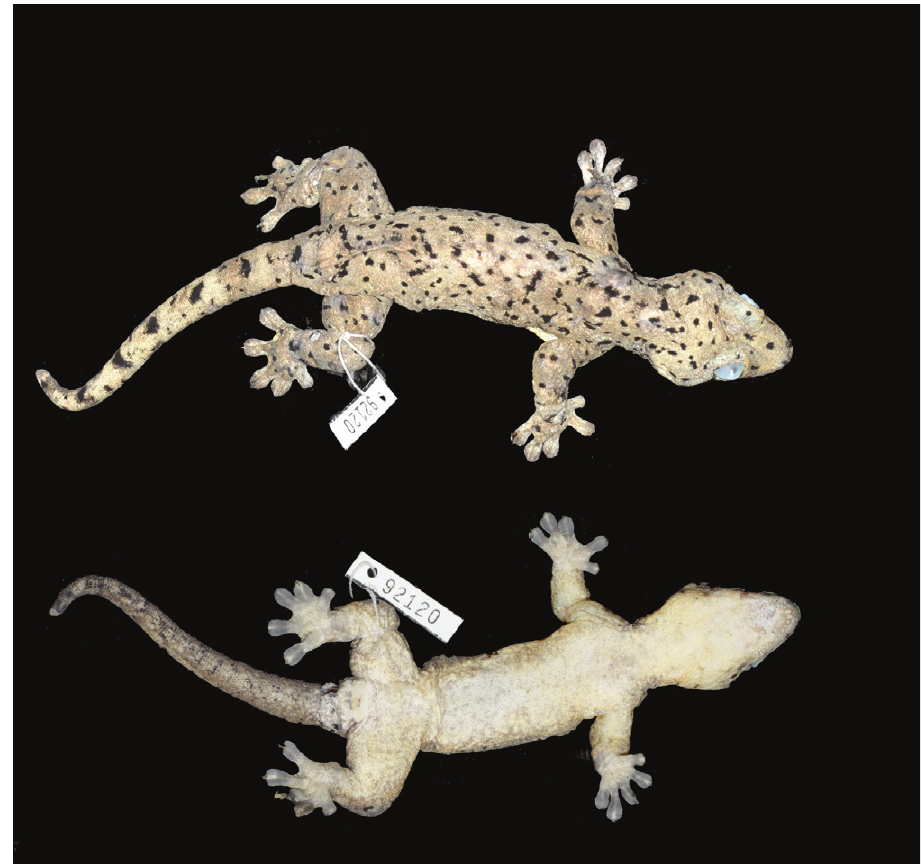
Figure 1. Holotype of Thecadactylus oskrobapreinorum (SMF 92120). SVL = 95.5